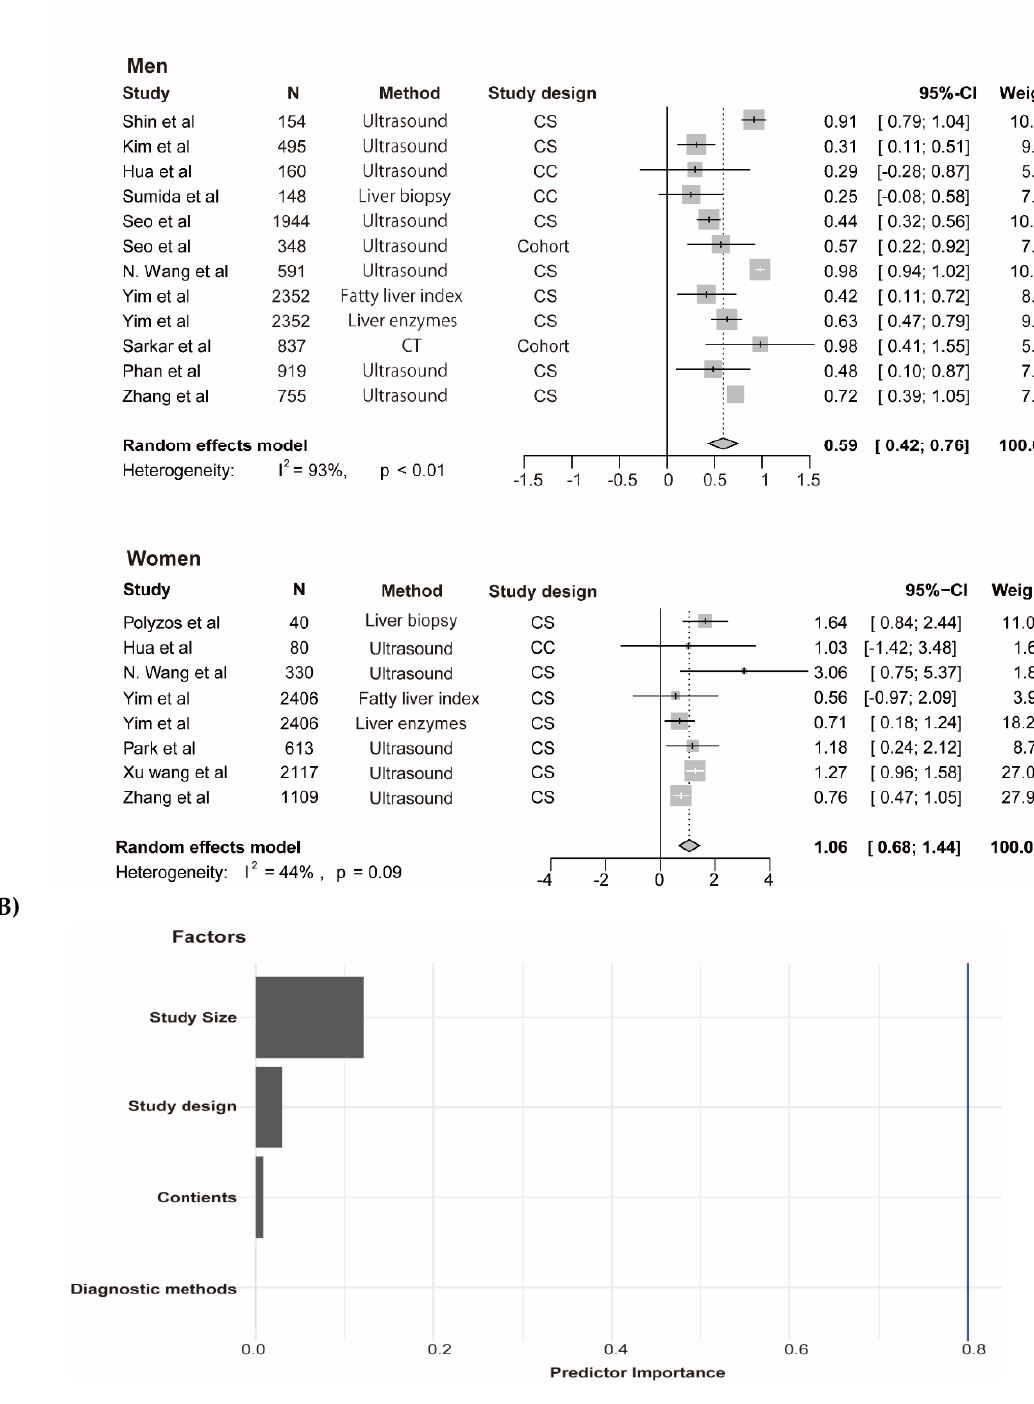
Figure 3. Association of testosterone with NAFLD and results of multivariable meta-regression analysis. ( A ) association of testosterone with NAFLD among men and women. The summary estimate (center of diamond) and 95% confidence interval (width of diamond) were synthesized by using a random effect model which is shown in bold. ( B ) the results of multivariable meta-regression analysis based on included studies for analysis of testosterone and NAFLD among men. Abbreviations: NAFLD, non-alcoholic fatty liver disease; CT, computed tomography; CS, cross-sectional; CC, case-control.